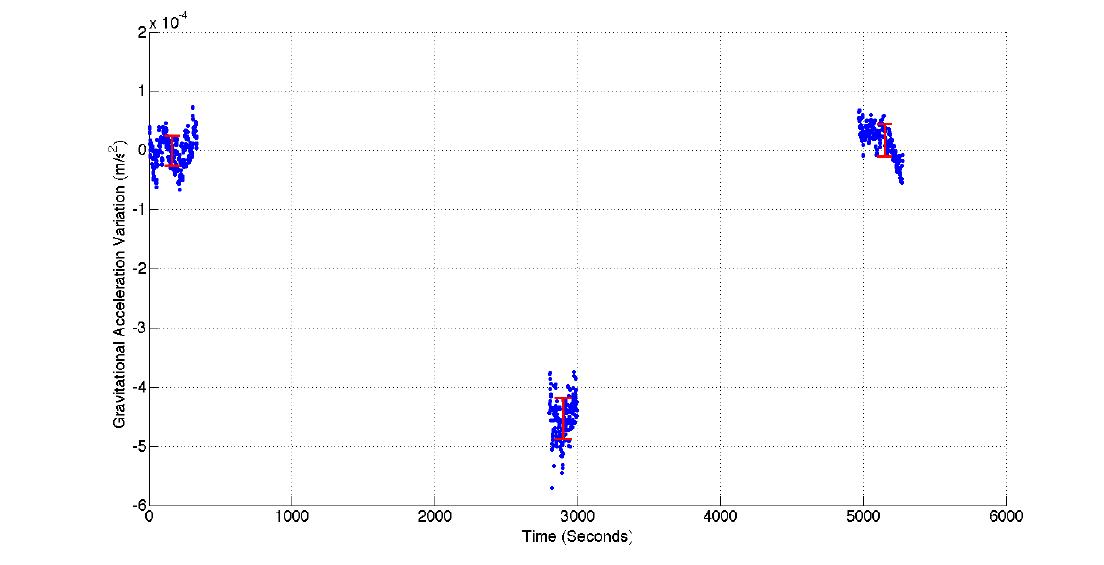
Figure 8. The data recorded on the field test up the Campsie hills. Three measurements can be observed in the graph: one at the base of the hill, one at the top, and a final measurement in the original location. The data has been zeroed at the value measured at the bottom of the hill. The red data points and error bars at each measurement location correspond to the mean value, and the standard deviation respectively. An acceleration variation of 4.62 × 10 − 4 ms − 2 is demonstrated. This value aligns with the estimations made for the Free-Air Effect and Bouguer